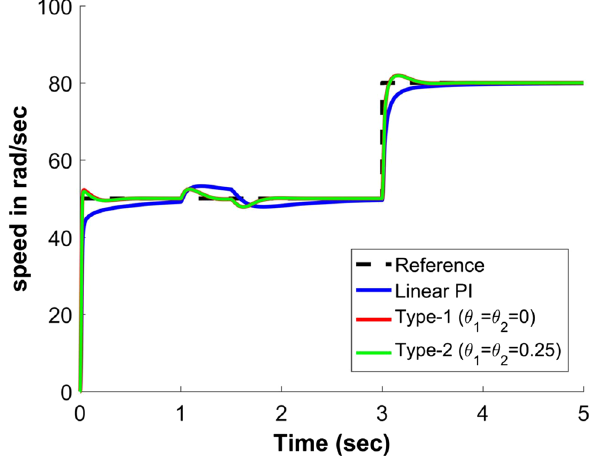
Fig. 16 Tracking responses of DCM with varying